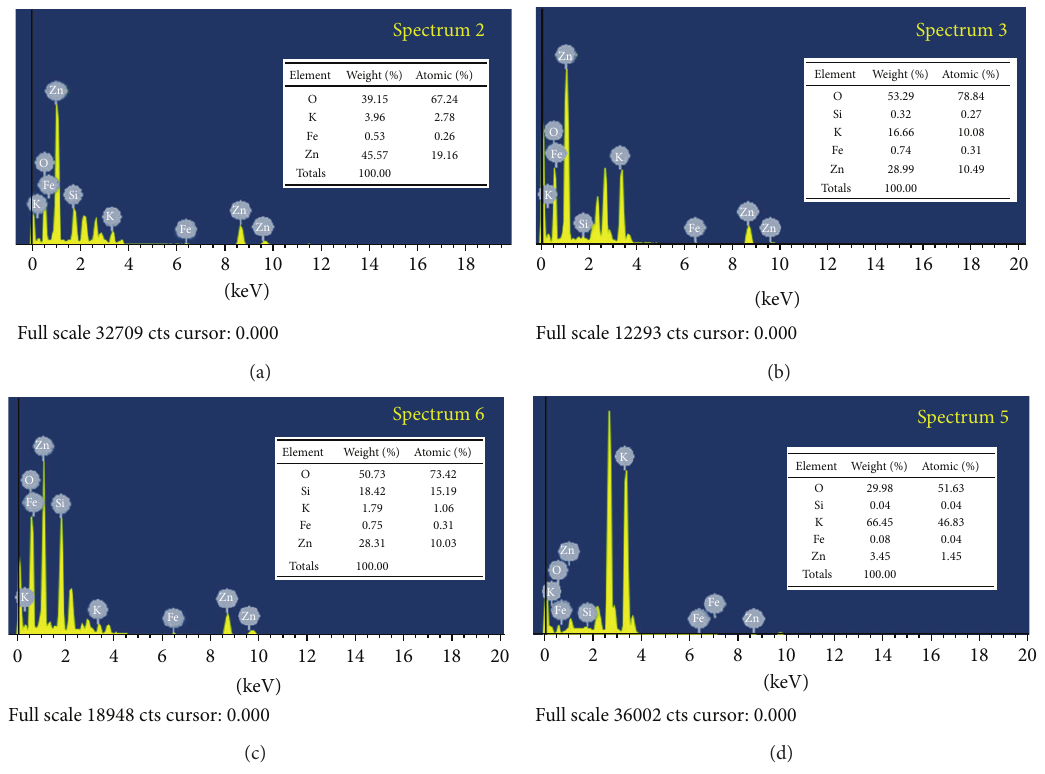
Figure 3: EDAX spectrum of (K (1%), Fe) codoped ZnO for Fe concentrations: (a) 1%, (b) 2%, (c) 3%, and (d)